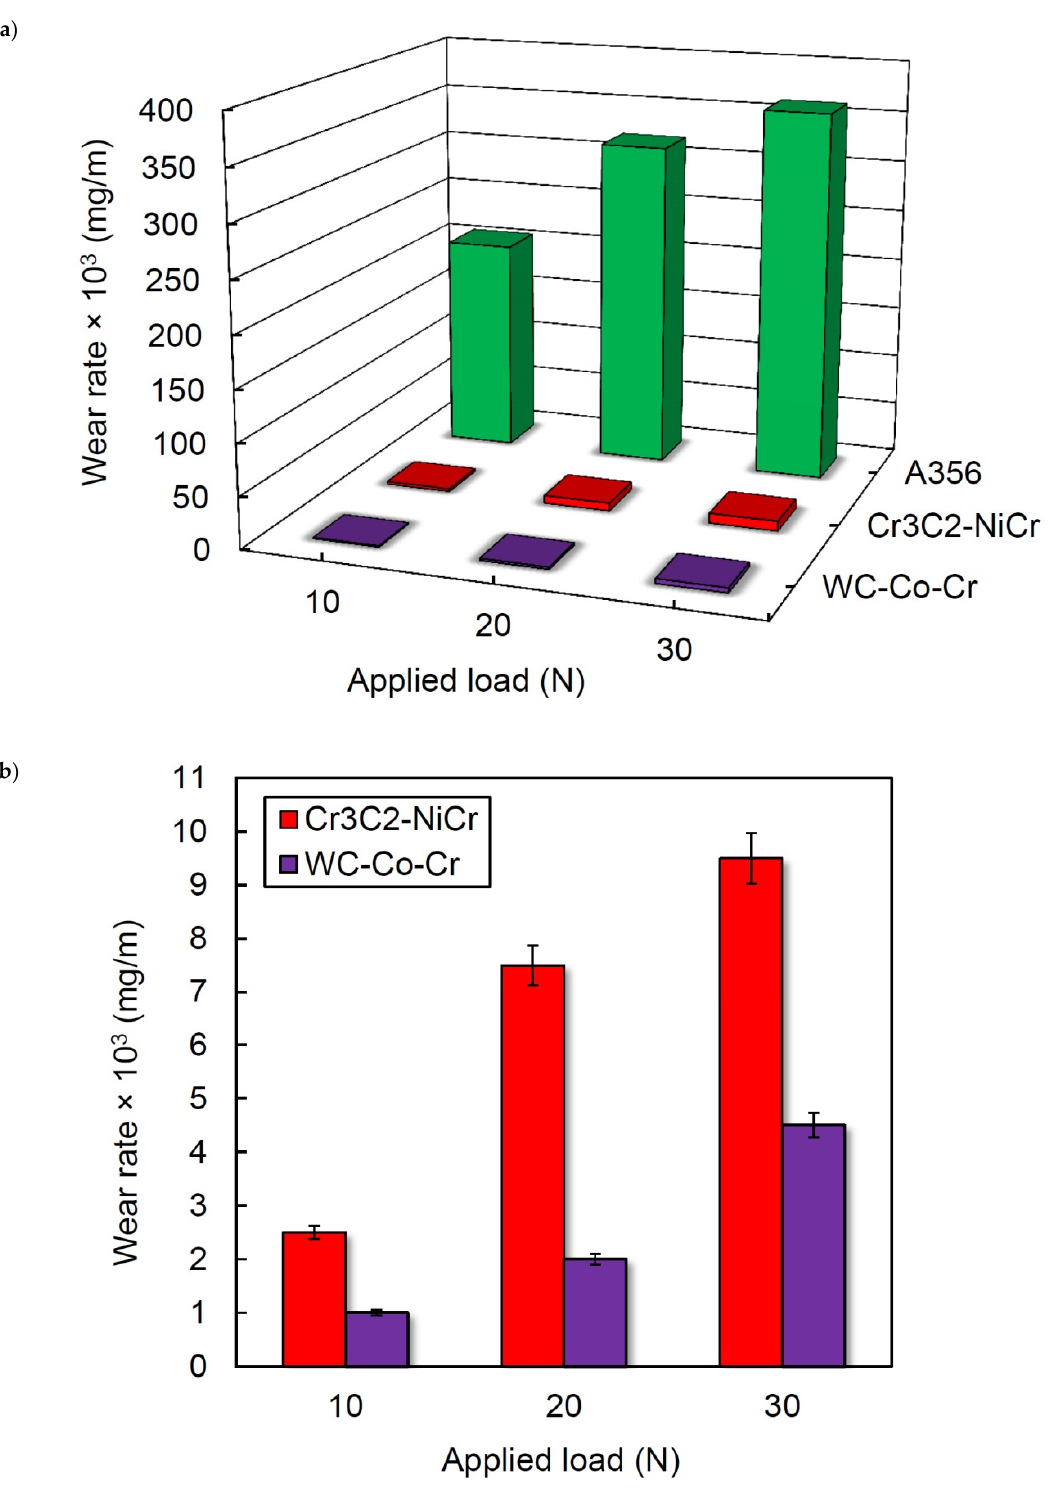
Figure 7. ( a ) Comparison between wear rates of A356 substrate and coatings at different applied loads; ( b ) closer comparison of Cr 3 C 2 -NiCr and WC-Co-Cr coatings.